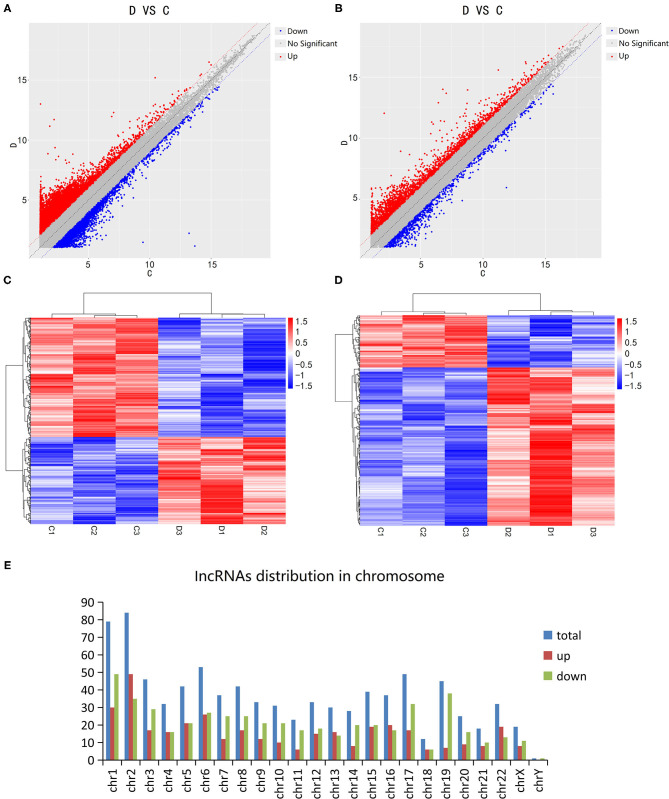
Expression levels of long non-coding RNAs (lncRNA) in dilated cardiomyopathy. Scatter plots were used to distinguish differentially expressed lncRNAs (A) and mRNAs (B). Hierarchical cluster analysis of lncRNAs (C) and mRNAs (D) with altered expression (P < 0.05, fold change >2) between the two groups. Distribution of dysregulated lncRNAs in human chromosomes (E). Red and blue represent upregulated and downregulated expression respectively. D indicates the experimental group; C indicates the control group.